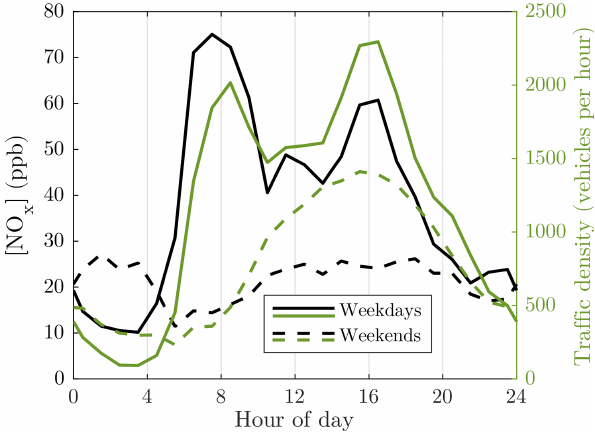
Figure 3. Average diurnal variations in nitrogen oxide (NO x ) con- centration, representing the concentration of the traffic-originated emissions overall and traffic density. The NO x concentration data measured with 1min time resolution are firstly averaged to 1h reso- lution; secondly, the averaged data from different days are averaged geometrically for the specific hours. Geometric averages are used for emissions, instead of arithmetic averages, because the logarith- mic nature of the concentrations would cause skewed frequency dis- tributions; thus, the highest concentrations would be weighted more than the lower ones. Arithmetic averaging is used for the traffic den-